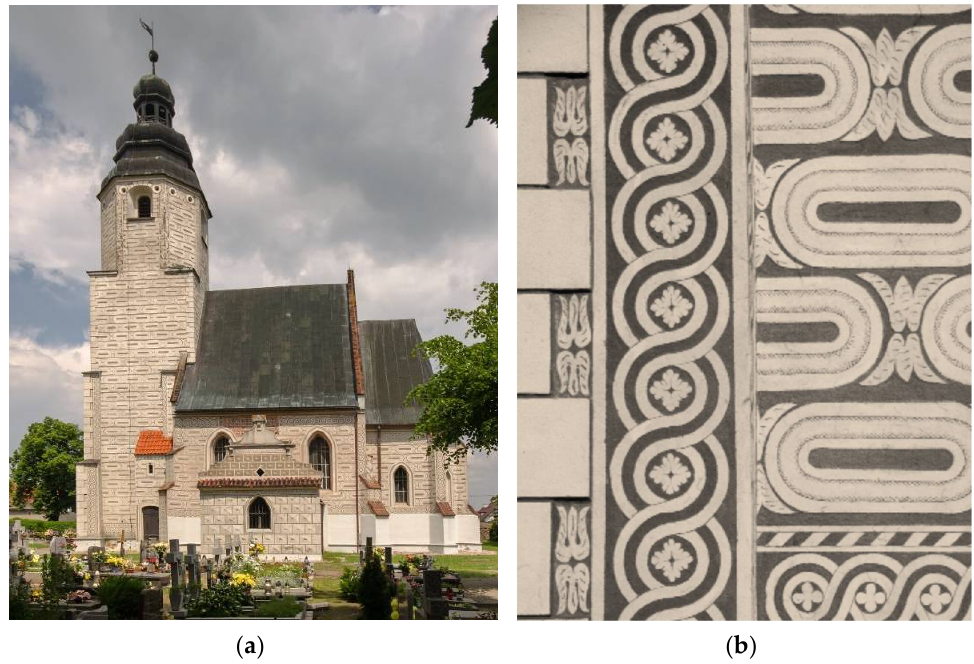
Figure 18. ( a , b ) The church in Gałów near Wrocław (Silesia) and the plaited and oval rustication decorations covering it. Photo author, 2011.